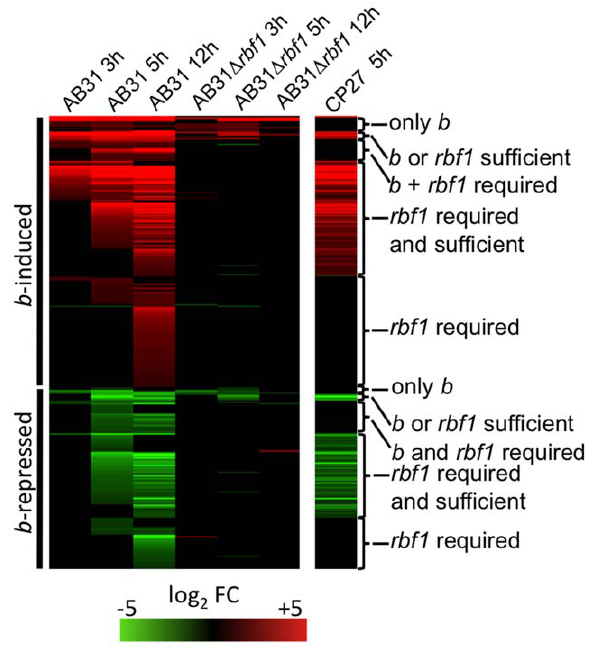
Figure 5. Rbf1 is required and sufficient for expression of b - dependent genes. The bE1 and bW2 genes were induced in strains AB31 or AB31 D rbf1 ; as a control for both strains, the incompatible bE2 and bW2 genes were induced in AB32. Strain CP27 (a2 D b:: P crg1 :rbf1 ) was used for induced expression of rbf1 , with strain JB2 ( a2 D b ) as control. Induction was performed by shifting the cells from array